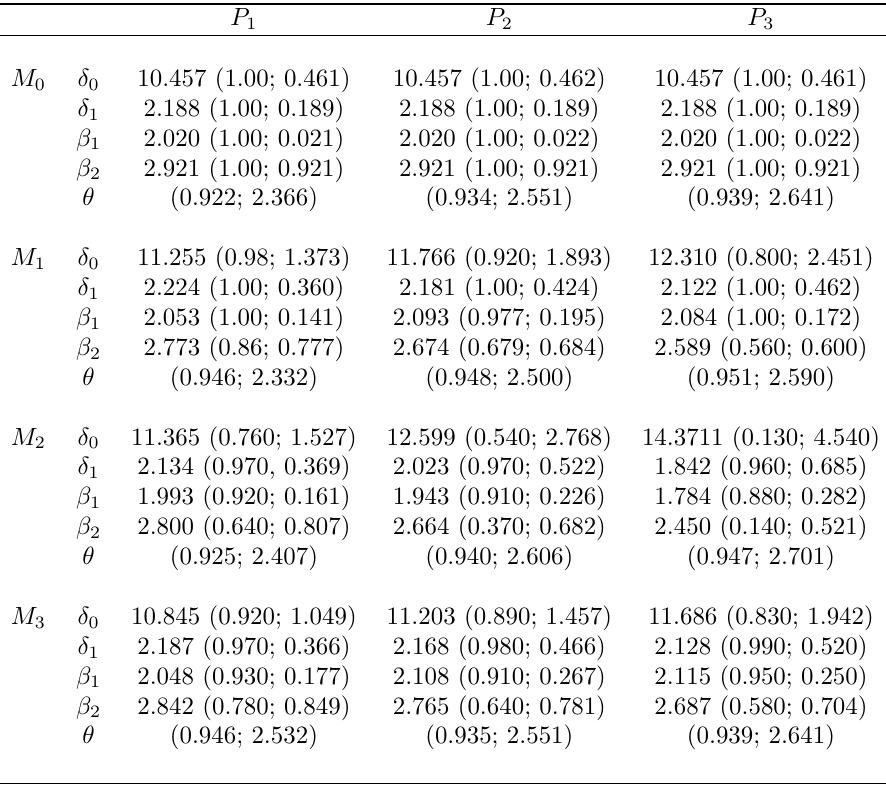
Invariant PRAM: posterior mean by misclassification probability P for different models and n i ranging from 5 to 20. In parentheses ACP and RMSE, respectively. In the last line, we show the average ACP and RMSE of the small area means.